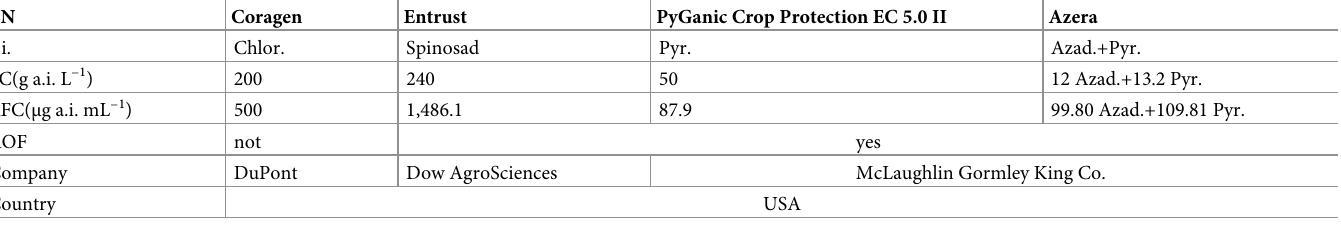
Table 1. Active ingredient (a.i.), formulation concentration (FC), recommended field concentration (RFC), authorized in organic farming (yes or not, AOF), com- pany, and country of brand name (BN) products.